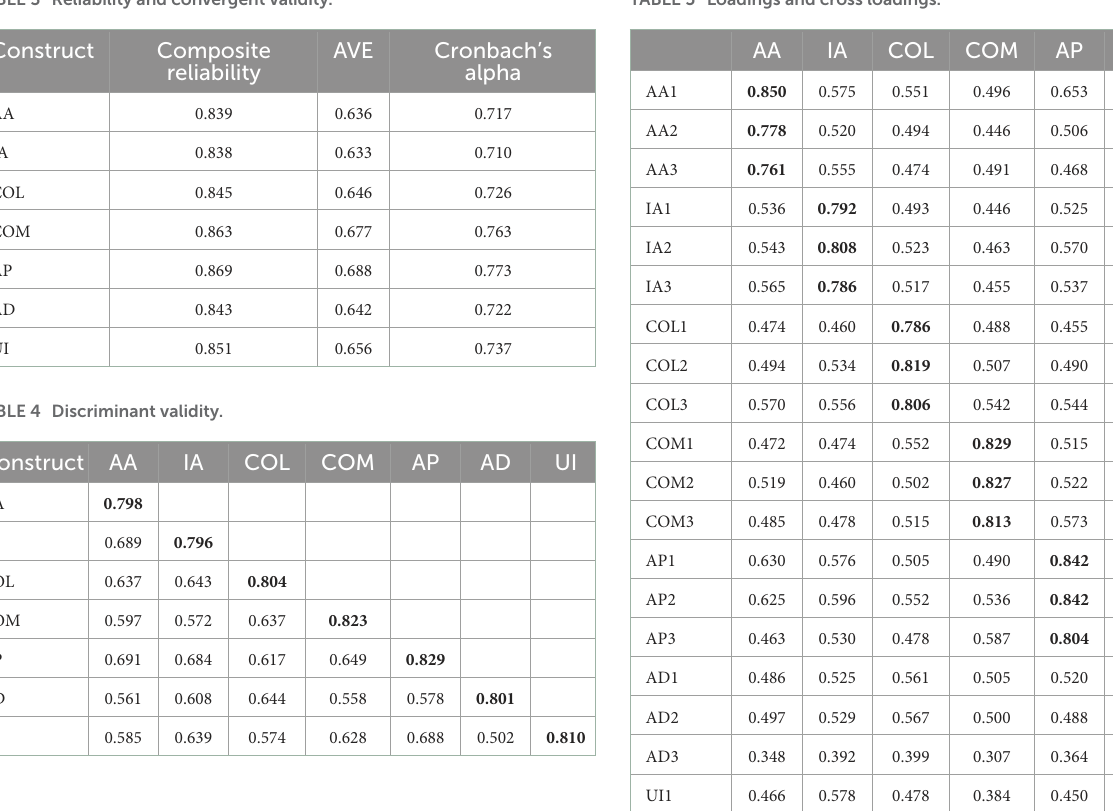
TABLE 3 Reliability and convergent validity.